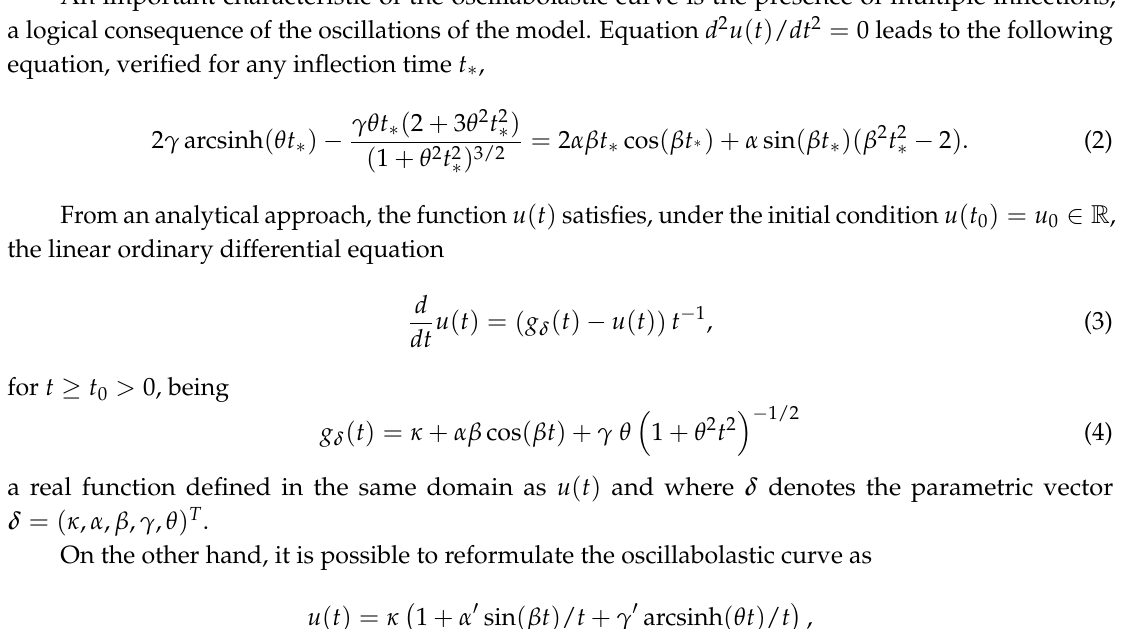
Figure 1. u 1 ( t ) curve ( a ), u 2 ( t ) curve ( b ), and oscillabolastic u ( t ) curve together with u 2 ( t ) (dashed line) moved to indicate the trend ( c ). The translation of u 2 ( t ) is the average between the difference u ( t ) − u 2 ( t ) for every t . Parameters: κ = 1, α = − 1, β = 1, γ = − 1, θ = 1, t 0 =